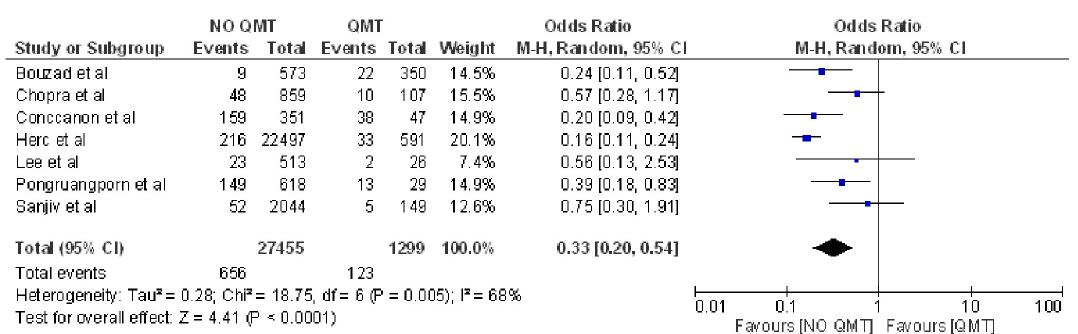
Fig 3. Forest plot of chemotherapy treatment and CLABSI.